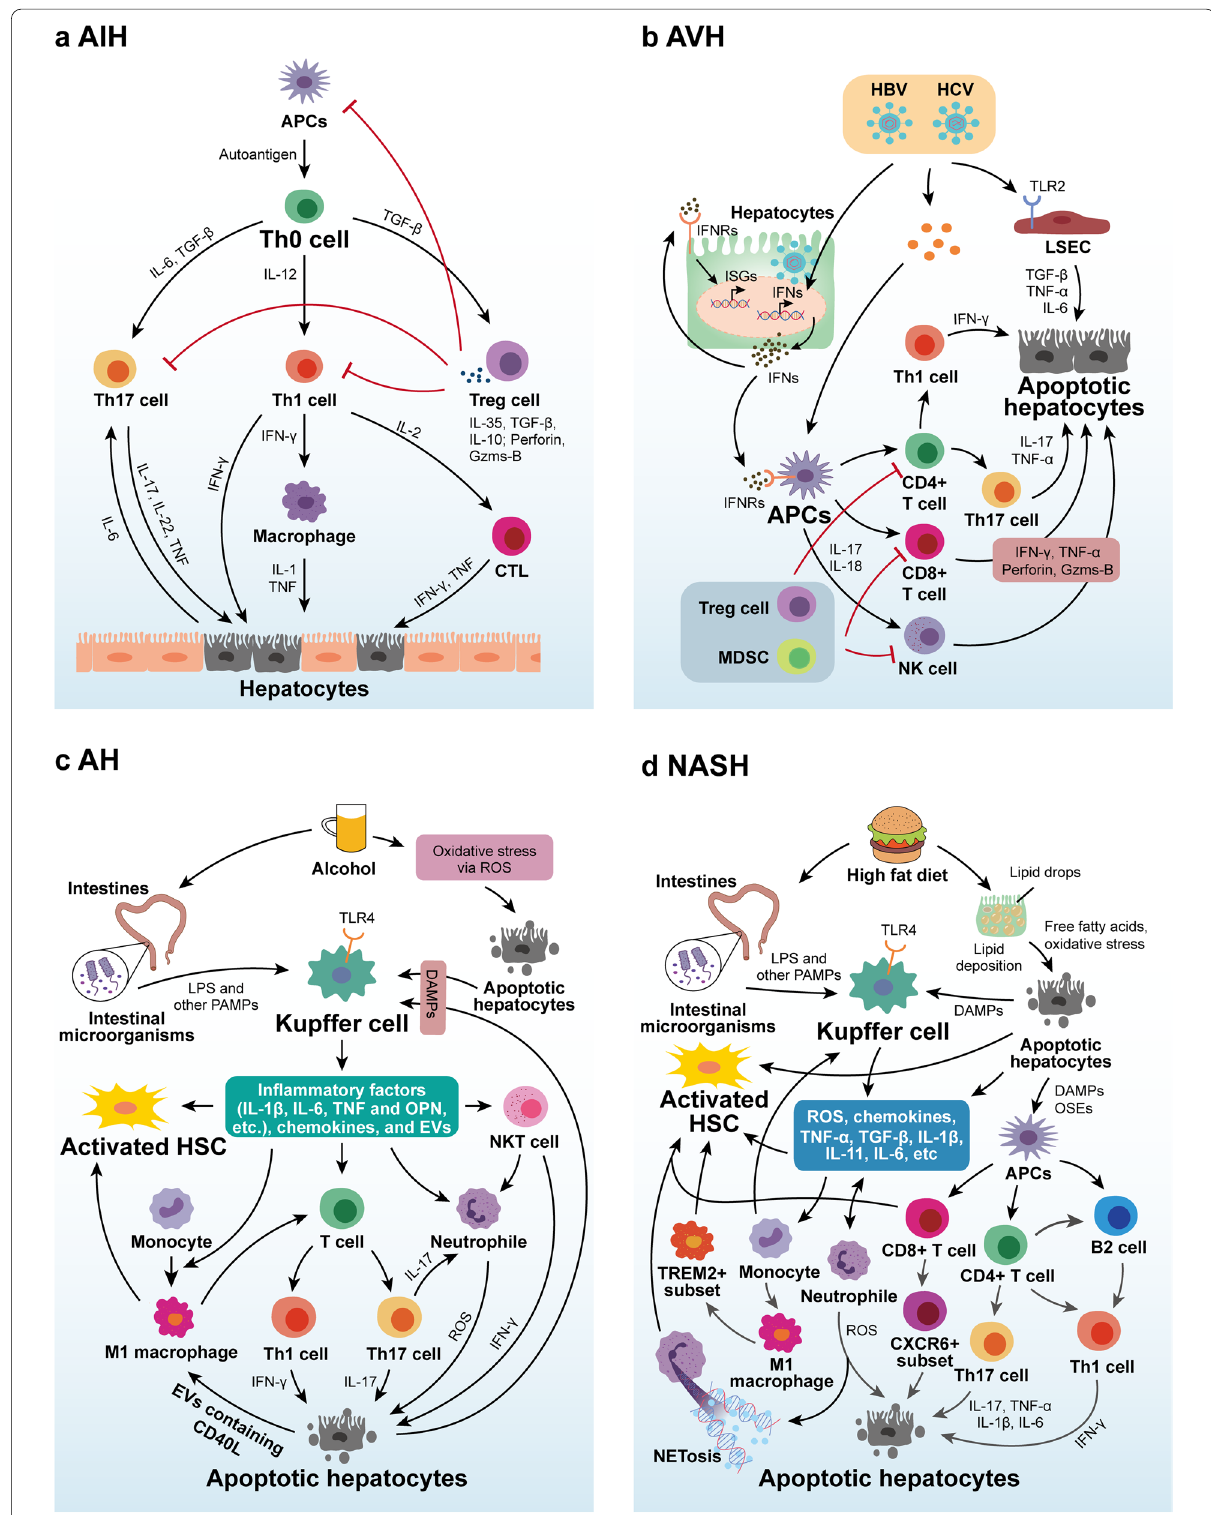
Fig. 3 Cellular and molecular mechanisms behind the imbalance of the immune microenvironment in liver diseases. Inflammatory liver diseases including ( a ) AIH, ( b ) AVH, ( c ) AH and ( d ) NASH share the same pathological features and manifest as hepatic inflammation, hepatocyte death and liver fibrosis mediated by innate and adaptive immune